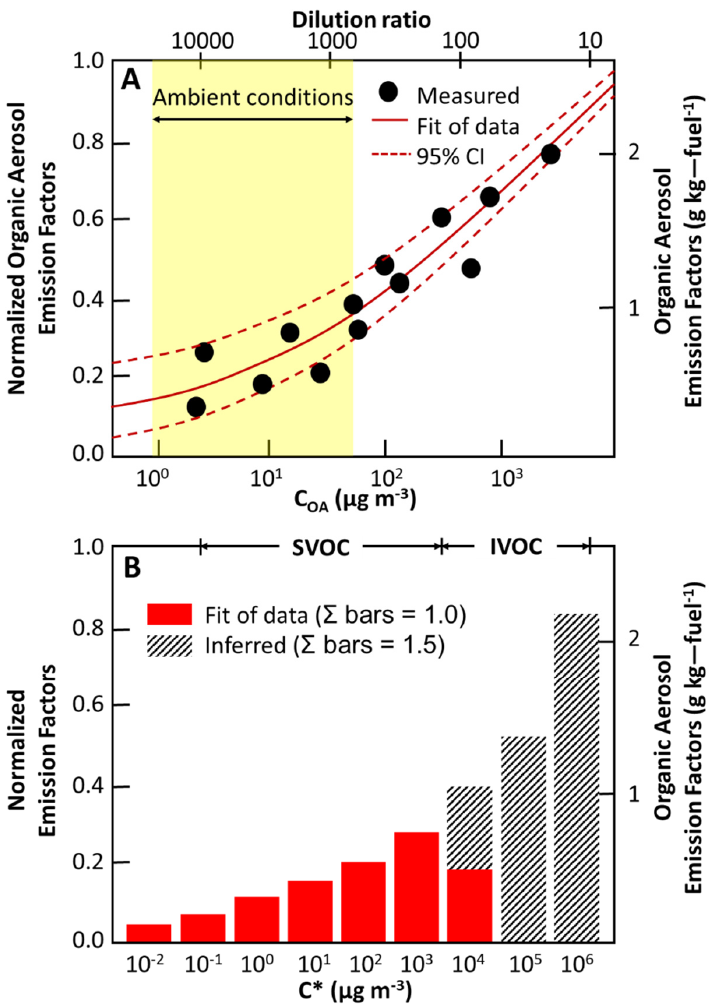
Figure 9. Normalised OA emission factor as a function of OA loading for a diesel motor exhaust at 300 K, adapted from Robinson et al. [151]. 300 K, adapted from Robinson et al.